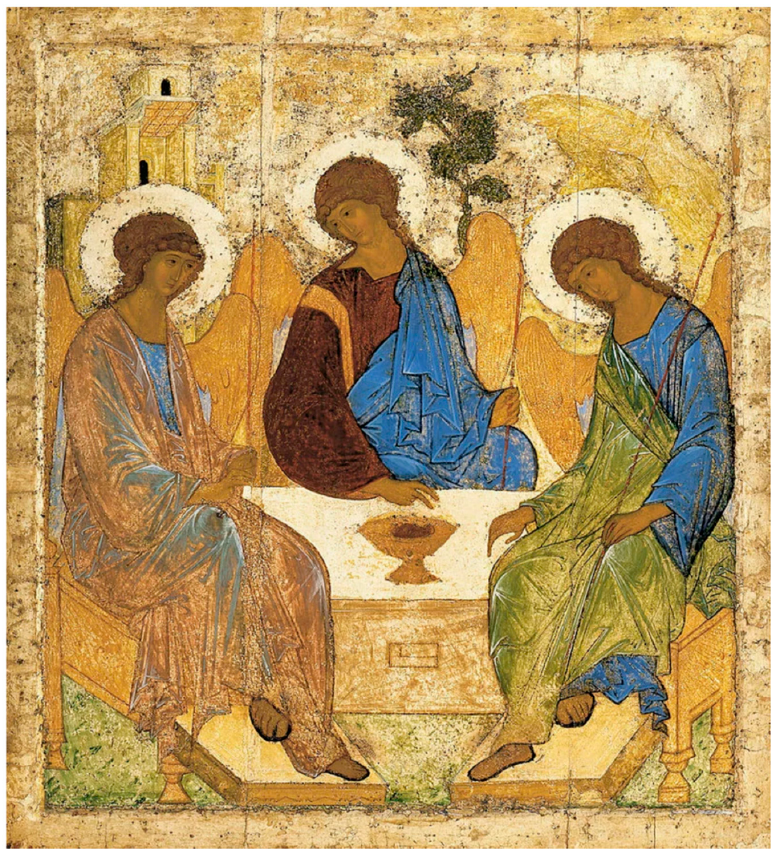
Figure 15. Andrei Rublev, Holy Trinity, 1425–1427.